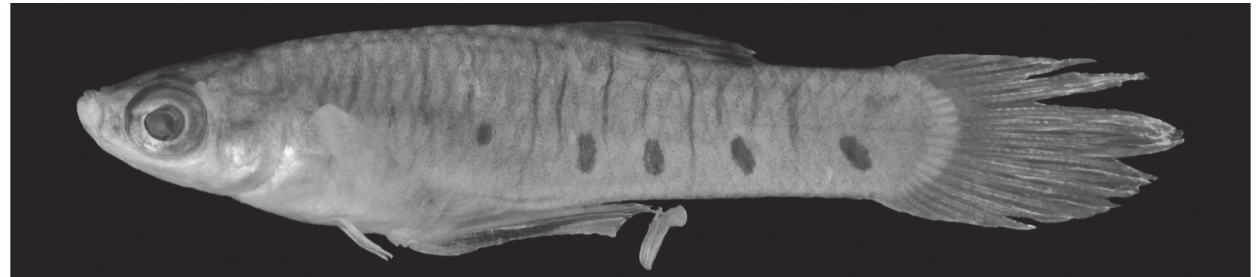
Fig. 1 . Phallotorynus pankalos , NUP 5839, male, 19.2 mm SL. Photo by Celso Ikedo (Nupélia-UEM). Fig. 2 . Phallotorynus pankalos, gonopodium, UNT 12493, 19.2 mm SL. Scale bar = 1 mm.